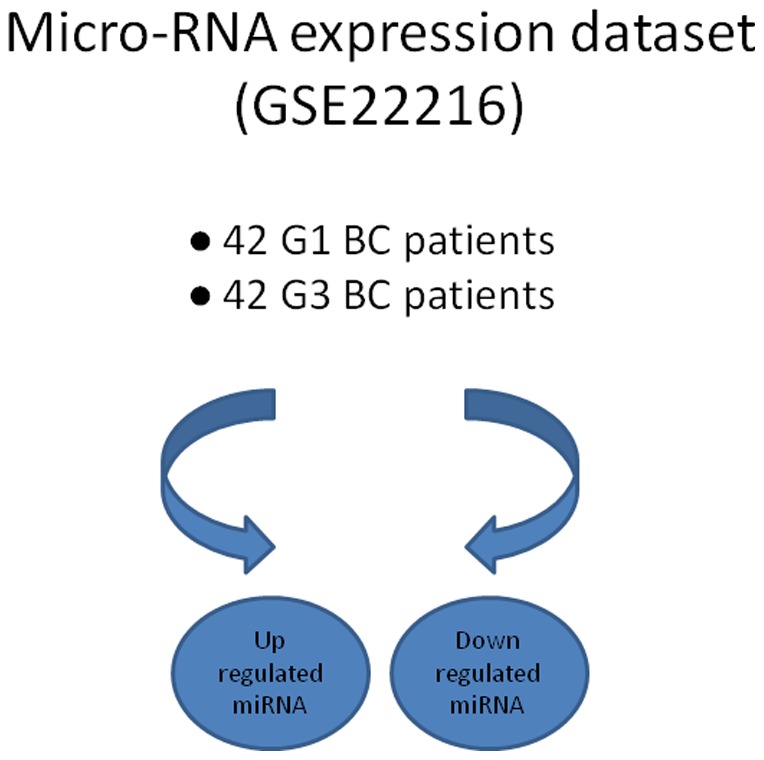
Schematic procedure for the identification of up and down regulated miRNAs.Identification of up and down regulated miRNAs.